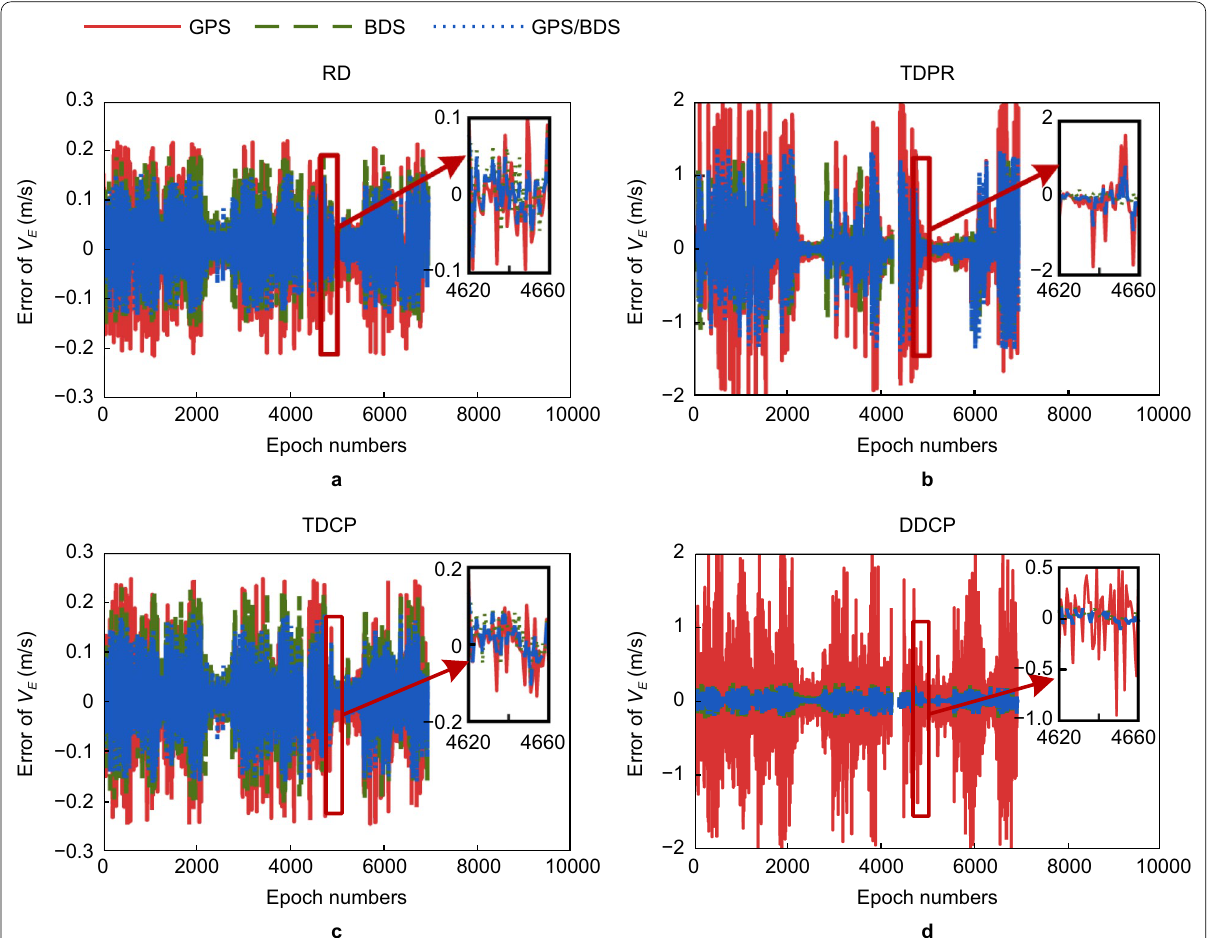
Fig. 7 Velocity determination accuracy and zoomed-in windows in east component with the RD- ( a ), TDPR- ( b ), TDCP- ( c ) and DDCP- ( d ) based methods in test